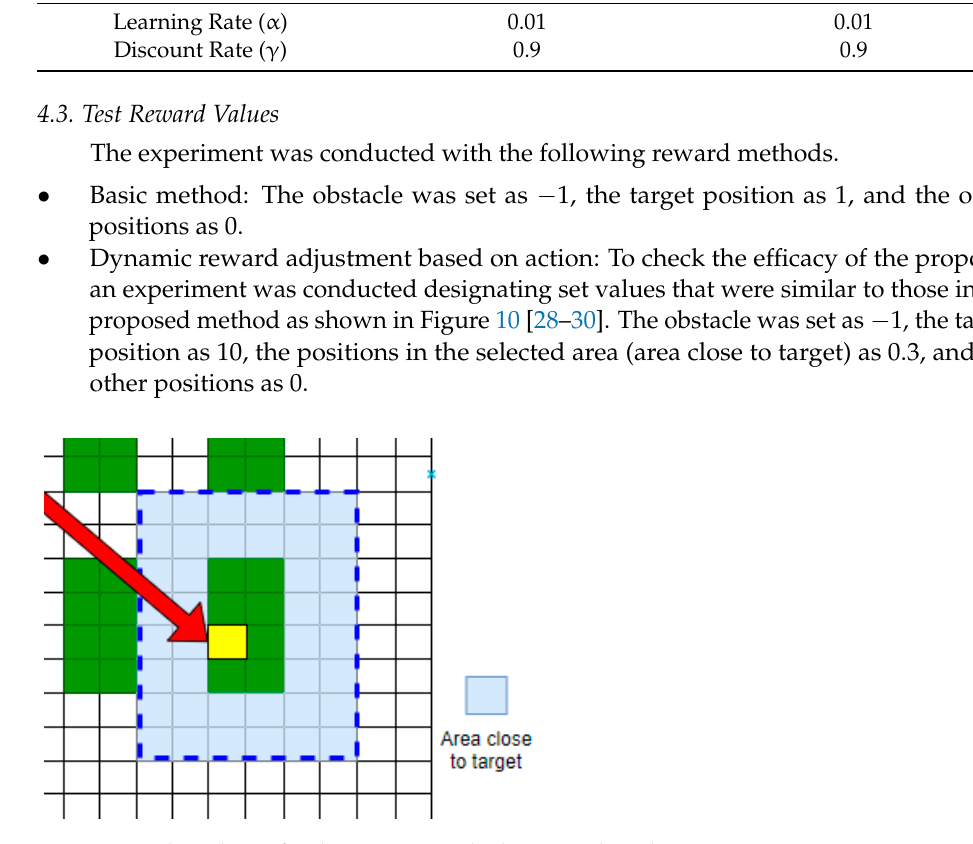
Figure 9. Target position of simulation experiment.